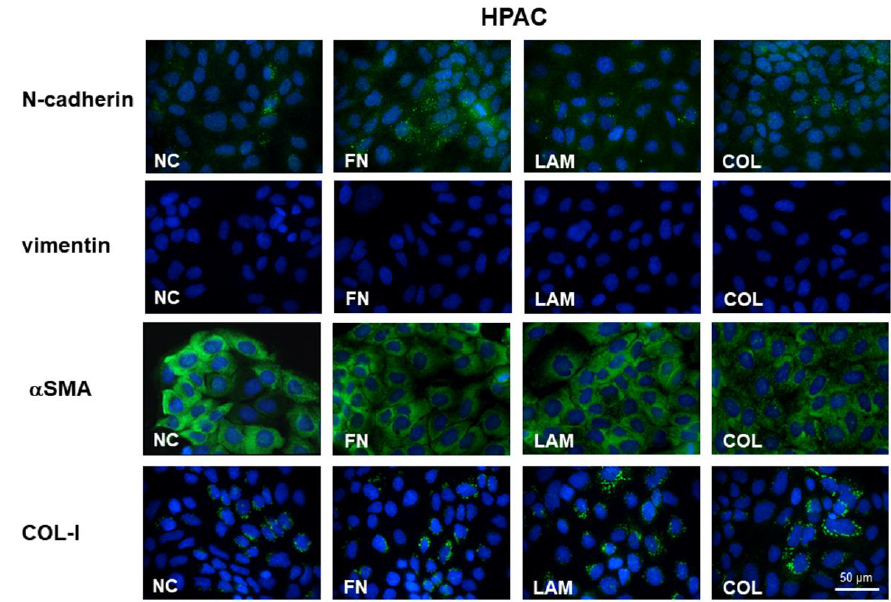
Figure 4. Immunofluorescence analysis of mesenchymal markers. Photomicrographs showing the expression of mesenchymal markers N-cadherin, vimentin, αSMA, and COL-I in HPAC cells cultured on FN, LAM, COL, or without coating (NC) (original magnification 60×).